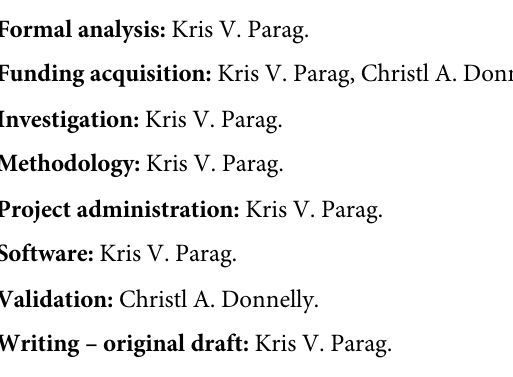
Fig B: Incidence curves for COVID-19. We present the simulated counts of daily new cases that underlie the results of Fig A . Fig C: Incidence curves for Ebola virus disease. We present the counts of daily new cases that underlie the results of Fig 2 of the main